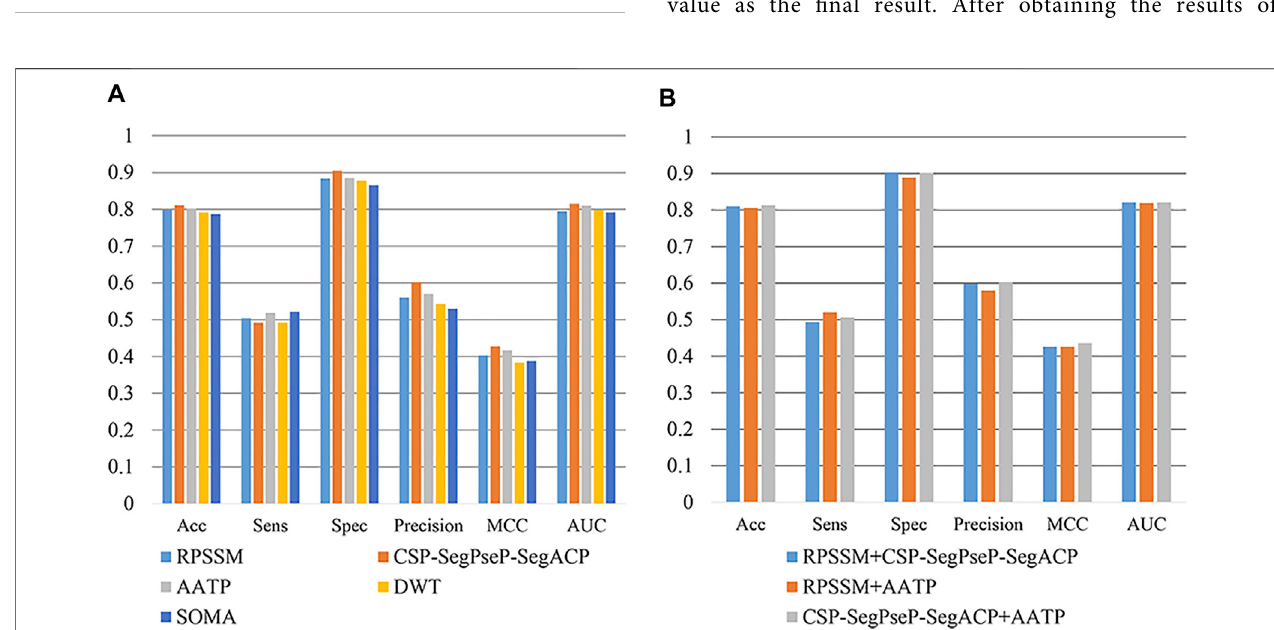
FIGURE 3 | (A) Comparison of single feature extraction methods. (B) Comparison of combining feature extraction methods.